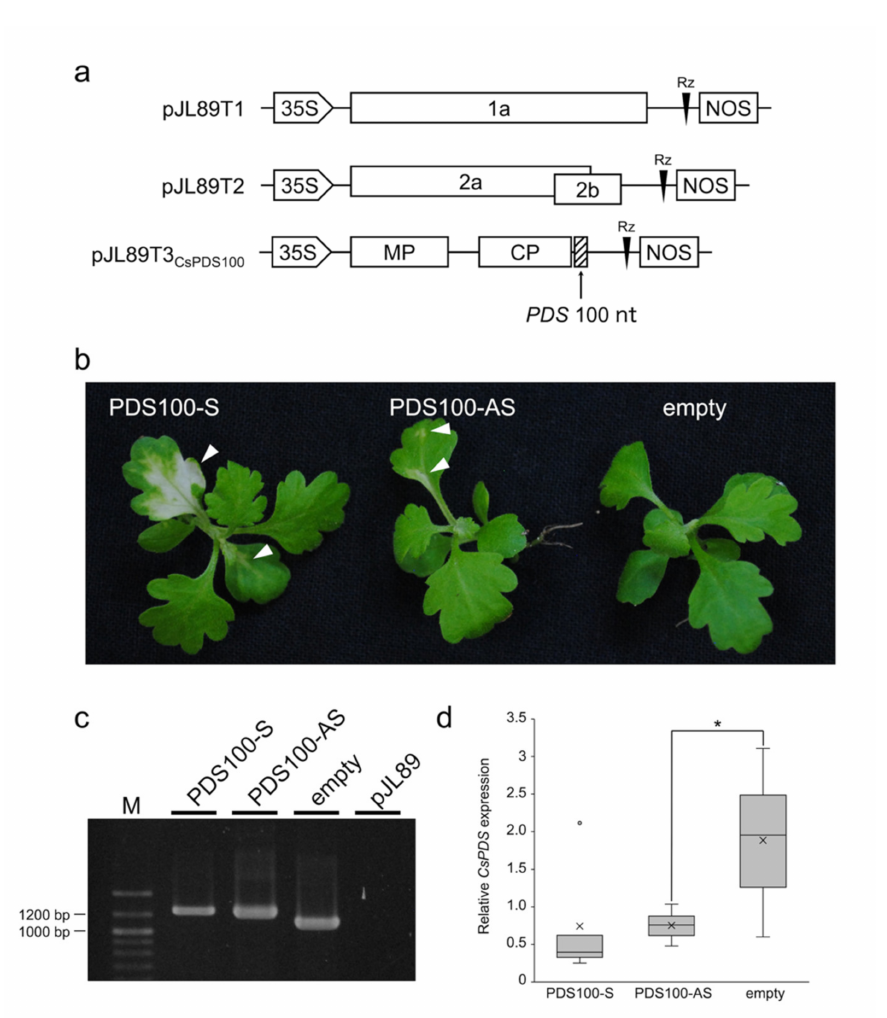
Figure 2. Virus-induced gene silencing (VIGS) induction in Chrysanthemum seticuspe by the tomato aspermy virus (TAV) vector. ( a ) Schematic representation of the VIGS constructs. The partial 100 nucleotides of the C. seticuspe phytoene desaturase ( PDS ) gene were introduced just downstream of the capsid protein (CP) open reading frame in TAV RNA3 (pJL89T3 CsPDS100 ) and agroinoculated with pJL89T1 and pJL89T2. The TAV genomes were cloned between the 35S promoter (35S) and the nopaline synthase terminator (NOS). The ribozyme sequence of hepatitis delta virus ribozyme (Rz) is located just downstream of the 3 (cid:48) untranslated region of TAV cDNA. ( b ) C. seticuspe infected with the TAV vector described in Panel A at 28 days postinoculation (dpi). The photobleaching areas are indicated by white arrowheads. ( c ) RT–PCR analysis of the TAV vector harboring the partial CsPDS sequence. RNA samples were extracted from C. seticuspe leaves at 28 dpi. pJL89 was used as a negative control. TAV not harboring the partial CsPDS sequence was used as the empty vector control. The RT–PCR product of the TAV vector harboring the partial CsPDS sequence was approximately 1200 base pairs (bp), whereas that of the TAV empty vector was approximately 1100 bp. ( d ) RT–qPCR analysis of CsPDS expression levels. RNA samples were extracted from C. seticuspe leaves at 28 dpi. TAV not harboring the partial CsPDS sequence was used as the empty vector control. Each RT–qPCR analysis was performed with five to six biological replicates. Boxes show the interquartile ranges including 25–75% of the values, and whiskers indicate the highest and lowest values of data. Horizontal lines and cross marks in boxes indicate the medians and means, respectively. The value outside 1.5 times the interquartile range between 25% and 75% of each group was considered an outlier and indicated with a dot. Asterisks indicate significant differences by Student’s t-test at p <